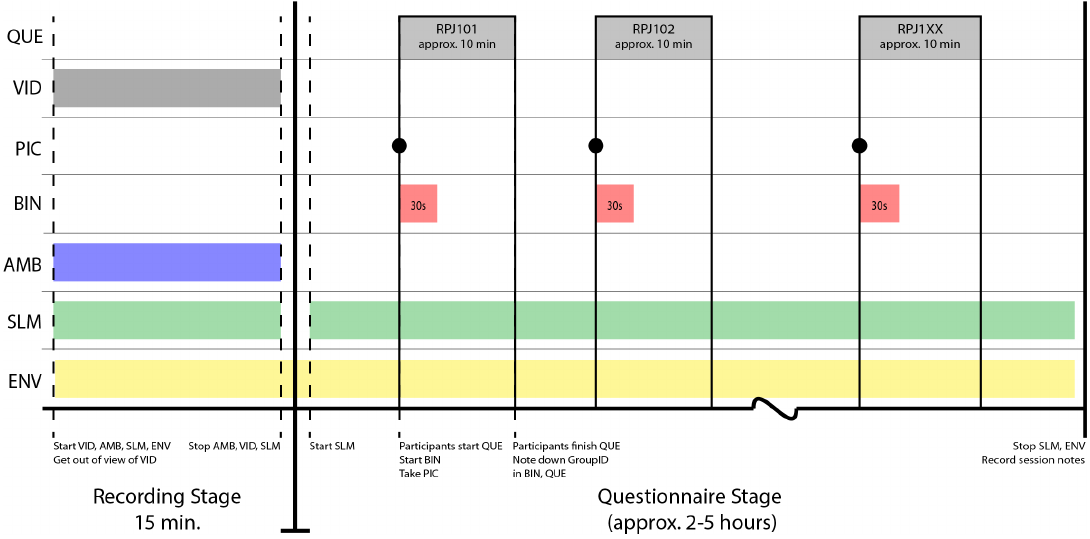
Figure 1. Timeline of the on site soundscape protocol. RegentsParkJapan (RPJ) is used as an example. Abbreviations as defined in Table 3—QUE: Questionnaires; VID: 360 ◦ video; PIC: Site pictures;